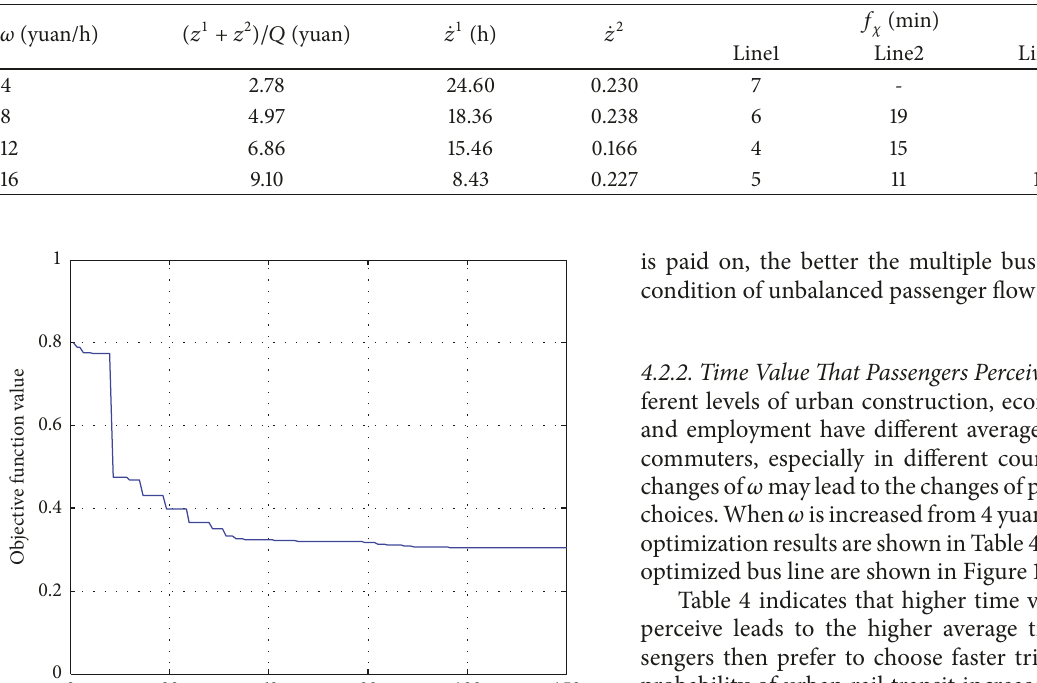
Table 4: The important values of the model under different values of 𝜔 .